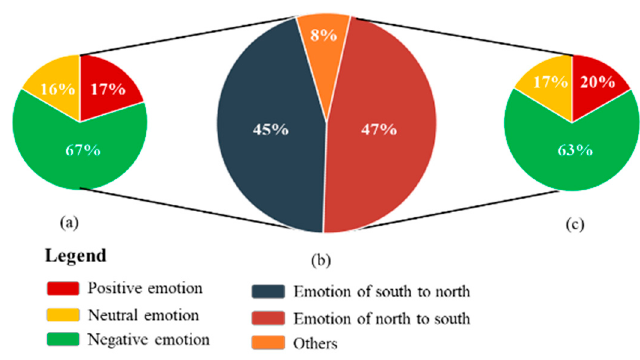
Figure 4. Emotion ratio pie chart under the influence of cultural differences between North and South.